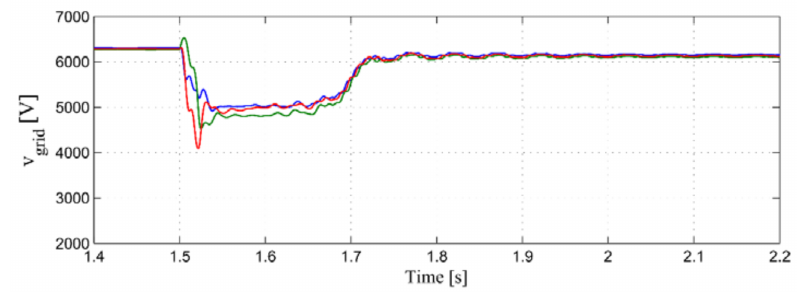
Figure 13. The RMS waveform of grid voltage due to starting motor.